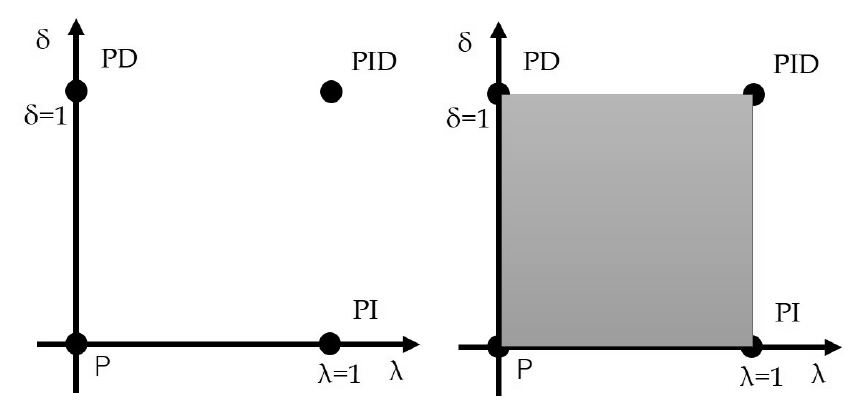
Figure 12. PID controller with the fractional